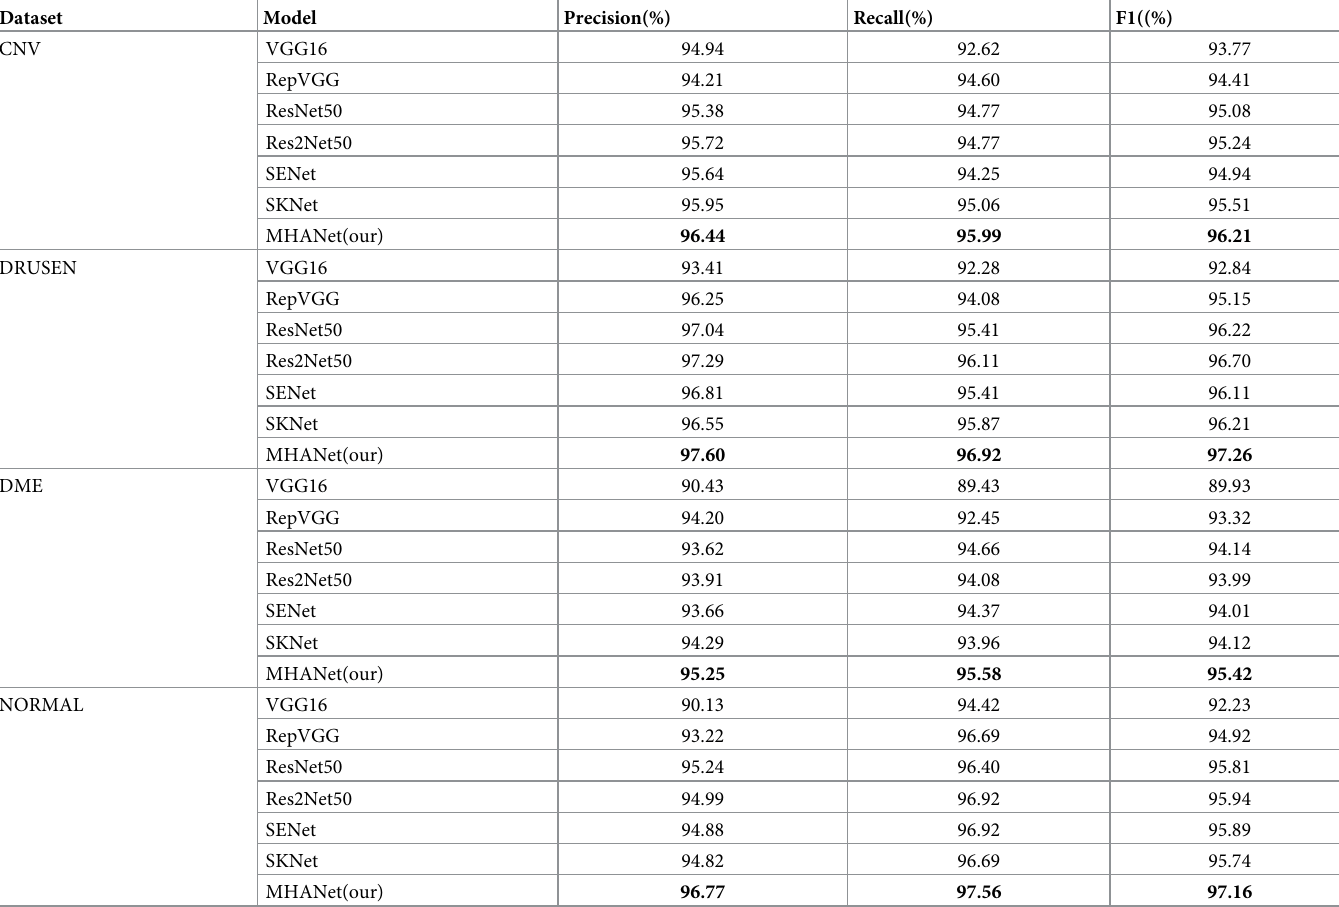
Table 6. Precision, Recall, F1 of Dataset2.